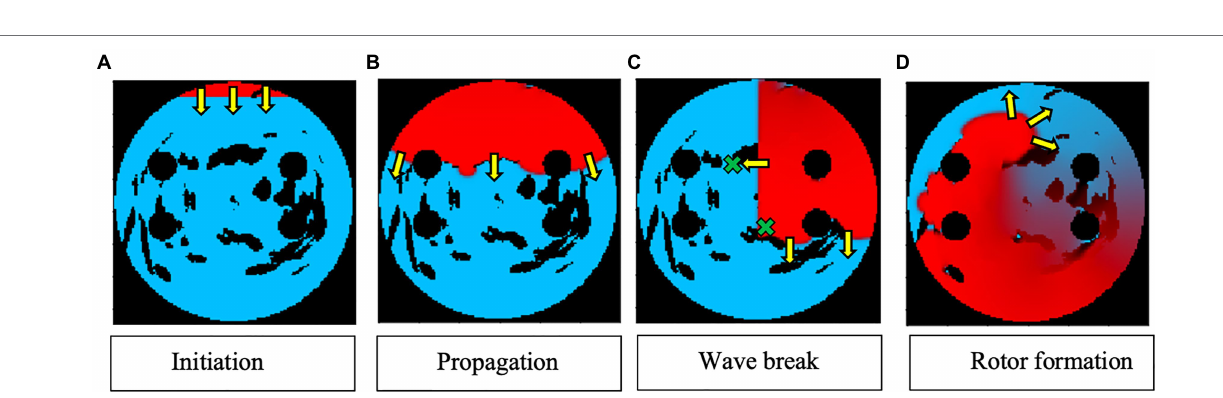
FIGURE 1 | Generating image-based 2D left atrial tissues. (A) LGE-MR image (greyscale) with segmented LA (red). (B) The 3D LA with LGE-MRI intensity distribution and the PVs and LA appendage (LAA) clipped. (C) The thresholded 3D LA with fibrosis in red and healthy tissue in blue. (D) The LA unwrapped onto a standardised 2D disk, with fixed four PVs and the LAA and fibrotic areas mapped. PVs and LAA are labelled in (B,D) .